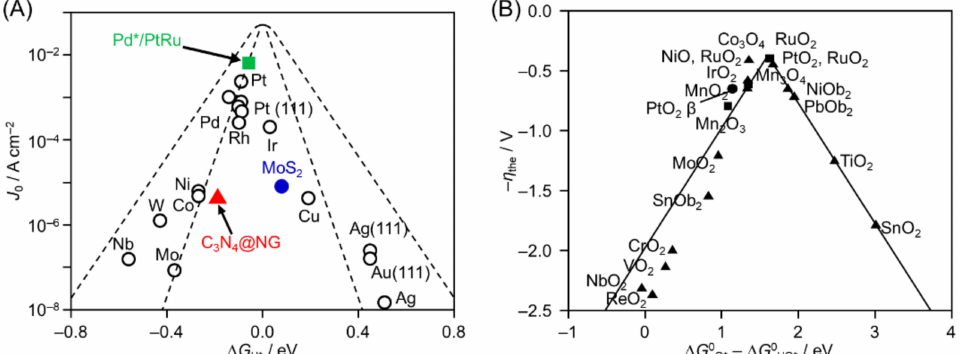
Figure 16. ( A ) The HER j 0 (exchange current density) values as a function of the free energy from the adsorption of H 2 ( ∆ G H* ) for the surfaces of various metals, alloys, and nonmetallic materi- als. ( B ) − η the (negative values of theoretical overpotential) values for the OER as a function of ( ∆ G 0 O* − ∆ G 0 HO* ). Reproduced with permission from references [178,217]. Copyright 2014 Springer Nature Limited and 2014